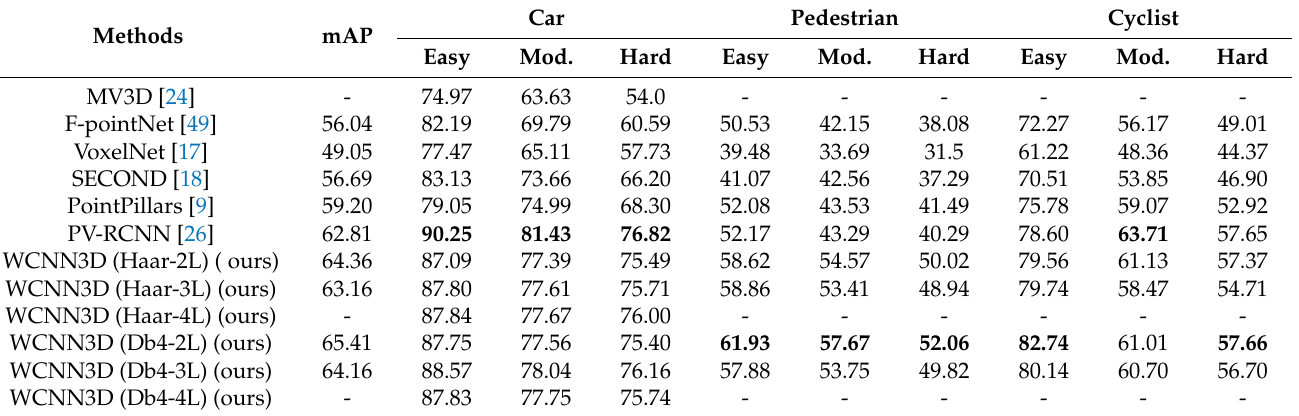
Table 2. Three-dimensional object detection result for Haar wavelet and Daubechies (Db4) wavelet on the KITTI test 3D detection benchmark. Note that ‘2L’ refers to 2-level wavelet decomposition, ‘3L’ refers to 3-level wavelet decomposition, and ‘4L’ refers to 4-level wavelet decomposition. The best results are in